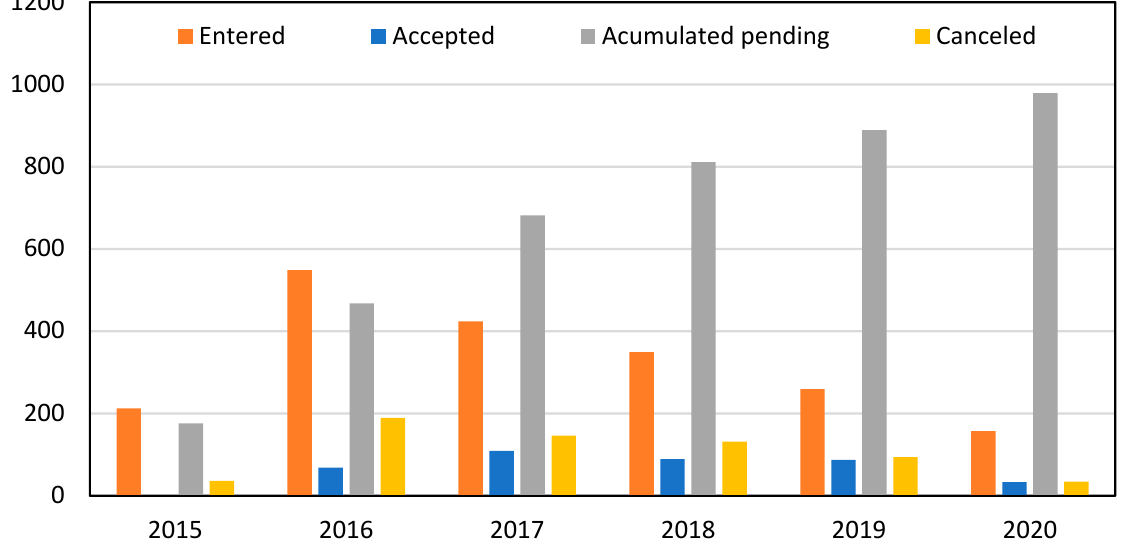
Figure 9. Number of interconnection requests per year from 2015 to 2020.